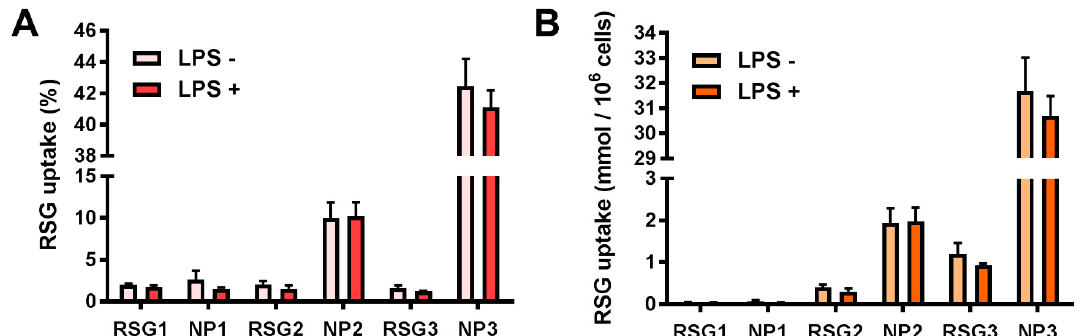
Figure 5. RSG uptake by RAW264.7 cells after 24 h incubation with free RSG or NPs at 3 different concentrations: RSG1, NP1 = 7.6 µ M; RSG2, NP2 = 59 µ M; RSG3, NP3 = 227 µ M. Uptake expressed as ( A ) percentage of RSG added amount and ( B ) mmol per million of cells.